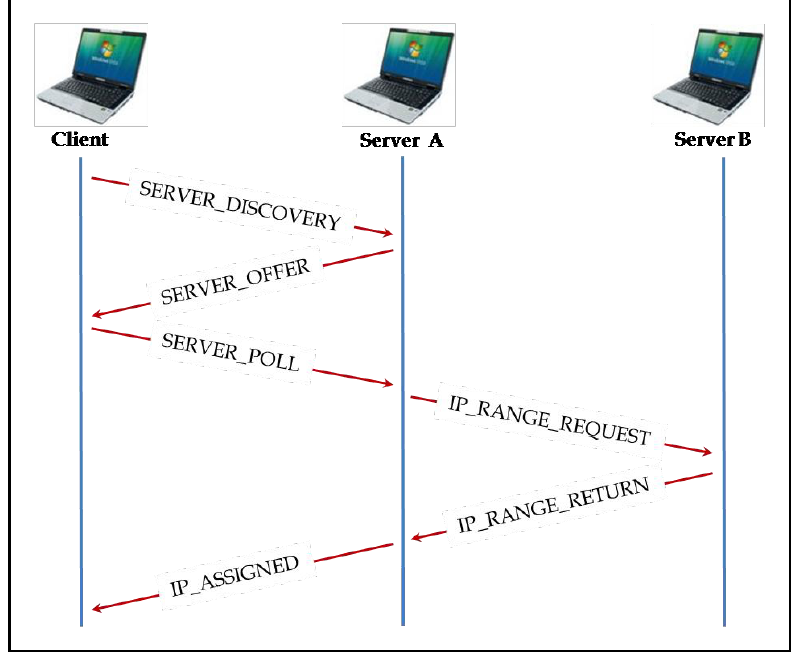
Figure 1. The messages interchanged in the process of a node joining the